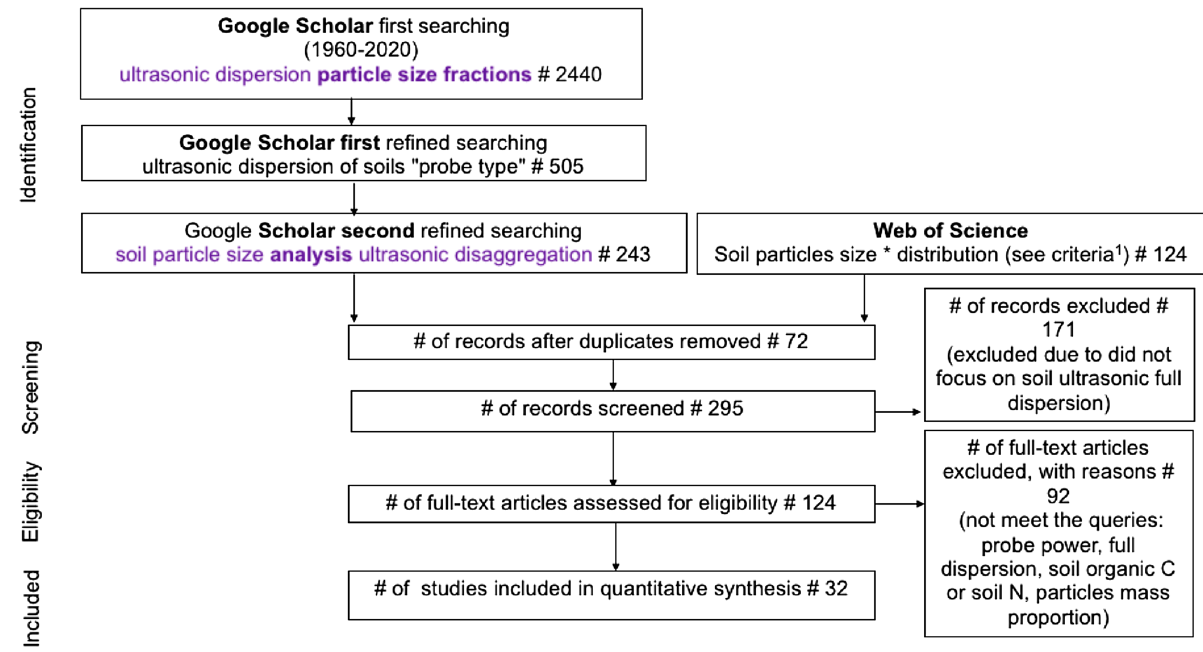
Figure 1. Flow chart of information through the different phases of a systematic meta-analysis (Liberati et al. 41 ). Google Scholar and Web of Science were used from Bases de Datos Suscritas-Bibliotecas UFRO (Universidad de La Frontera): http:// bibli otecas. ufro. cl/ recur sos- digit ales/ bases- de- datos- suscr itas/. Search string (and search string development) are indicated in the text inset in the Figure. Main drivers indicated in bold.